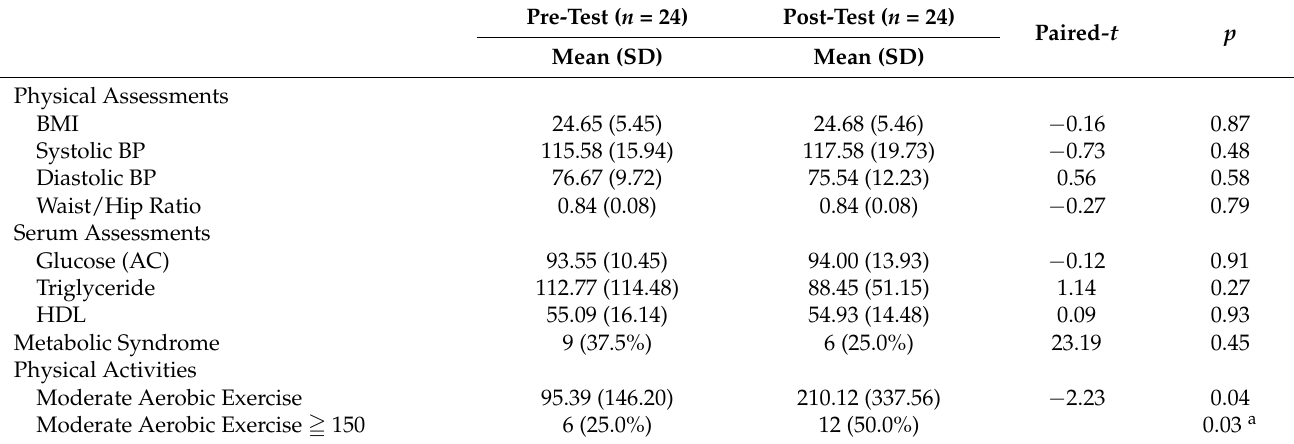
Table 4. Differences in physical and physiological variables between pre- and